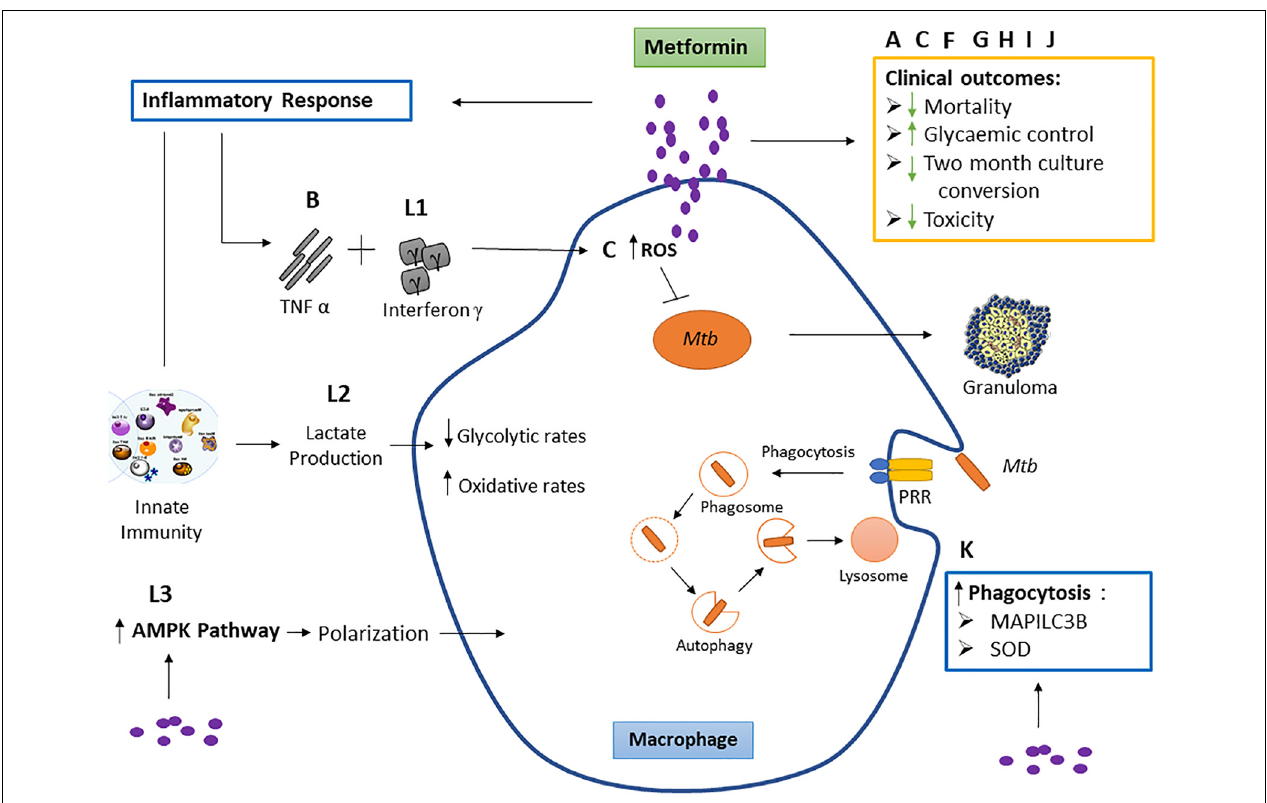
FIGURE 2 | The effect of metformin on macrophage function and clinical outcomes. Studies labeled A, C, F, G, H, I, and J represent the effect of metformin on respective clinical outcomes. These include reduced mortality, 2-month culture conversion and toxicity, and improved glycemic control. Studies B and L: outcome 1 show the effect of metformin on tumor necrosis factor (TNF)- α and interferon γ . TNF- α acts together with interferon γ , causing the production of reactive nitrogen intermediates and facilitating the tuberculostatic function of macrophages and the migration of immune cells to the infection site, contributing to granuloma formation. Study C shows metformin to increase macrophage reactive oxygen species (ROS) production. Evidence suggests that macrophage-produced ROS is responsible for increasing macrophage microbicidal activity by directly killing bacteria (Tan et al., 2016). This study is not part of the inclusion criteria. Study K observes metformin increases superoxide dismutase (SOD) and microtubule-associated proteins 1A/1B light chain 3B (MAP1LC3B). Mycobacterium tuberculosis (Mtb) binds the pattern recognition receptor (PRR) on the macrophage which initiates phagocytosis. Superoxide dismutase (SOD) (produced as a by-product